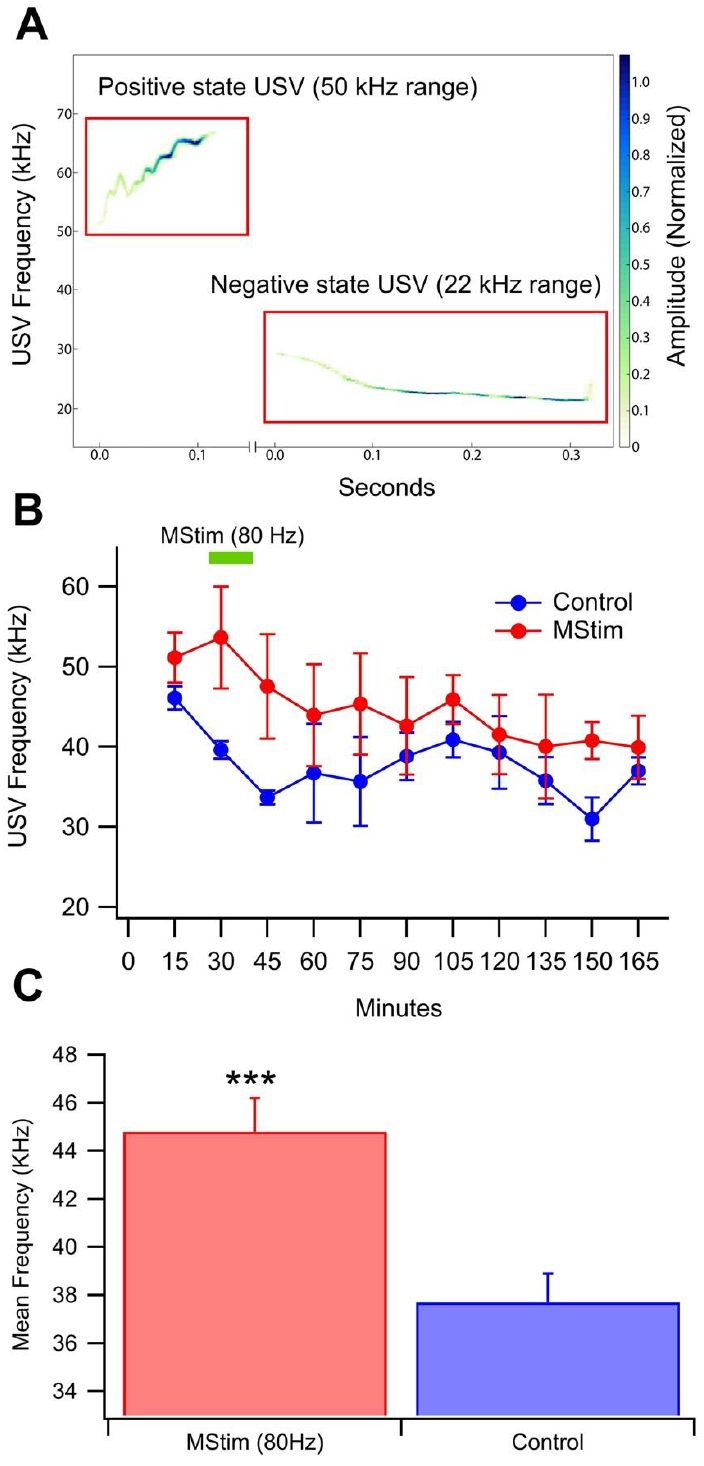
Figure 6. Effect of MStim on the frequency of USVs. USVs were recorded in sound-attenuating cham- bers during a 2.5 h session. ( A ) Representative traces of calls that fall within the 50 kHz and 22 kHz ranges. ( B ) Time response of the USVs comparing positive and negative calls. ( C ) Comparison of the mean frequency when all times are collapsed between control and MStim. Mechanical stimulation significantly increased the mean vocalization frequency when compared to control, suggesting an induction of a relatively higher positive affective state. Asterisks (***) indicate significance level p <